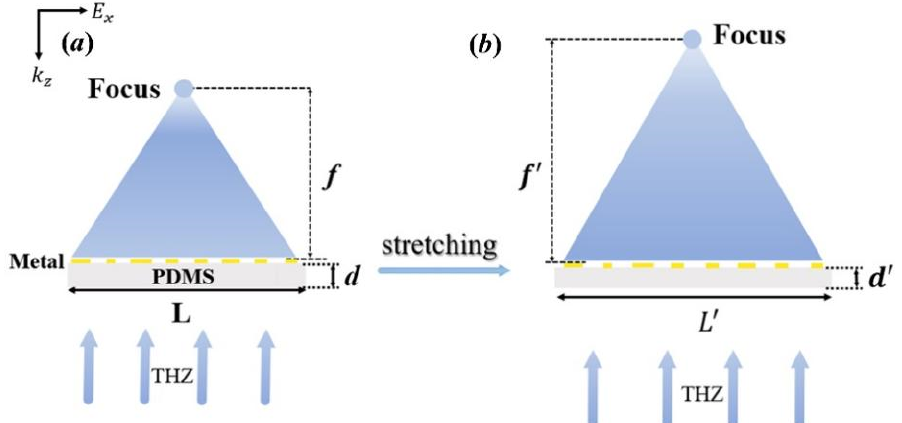
Figure 3. Schematic diagram of the change in the meta-lens before and after stretching. ( a ) Before substrate stretching; ( b ) after substrate stretching.